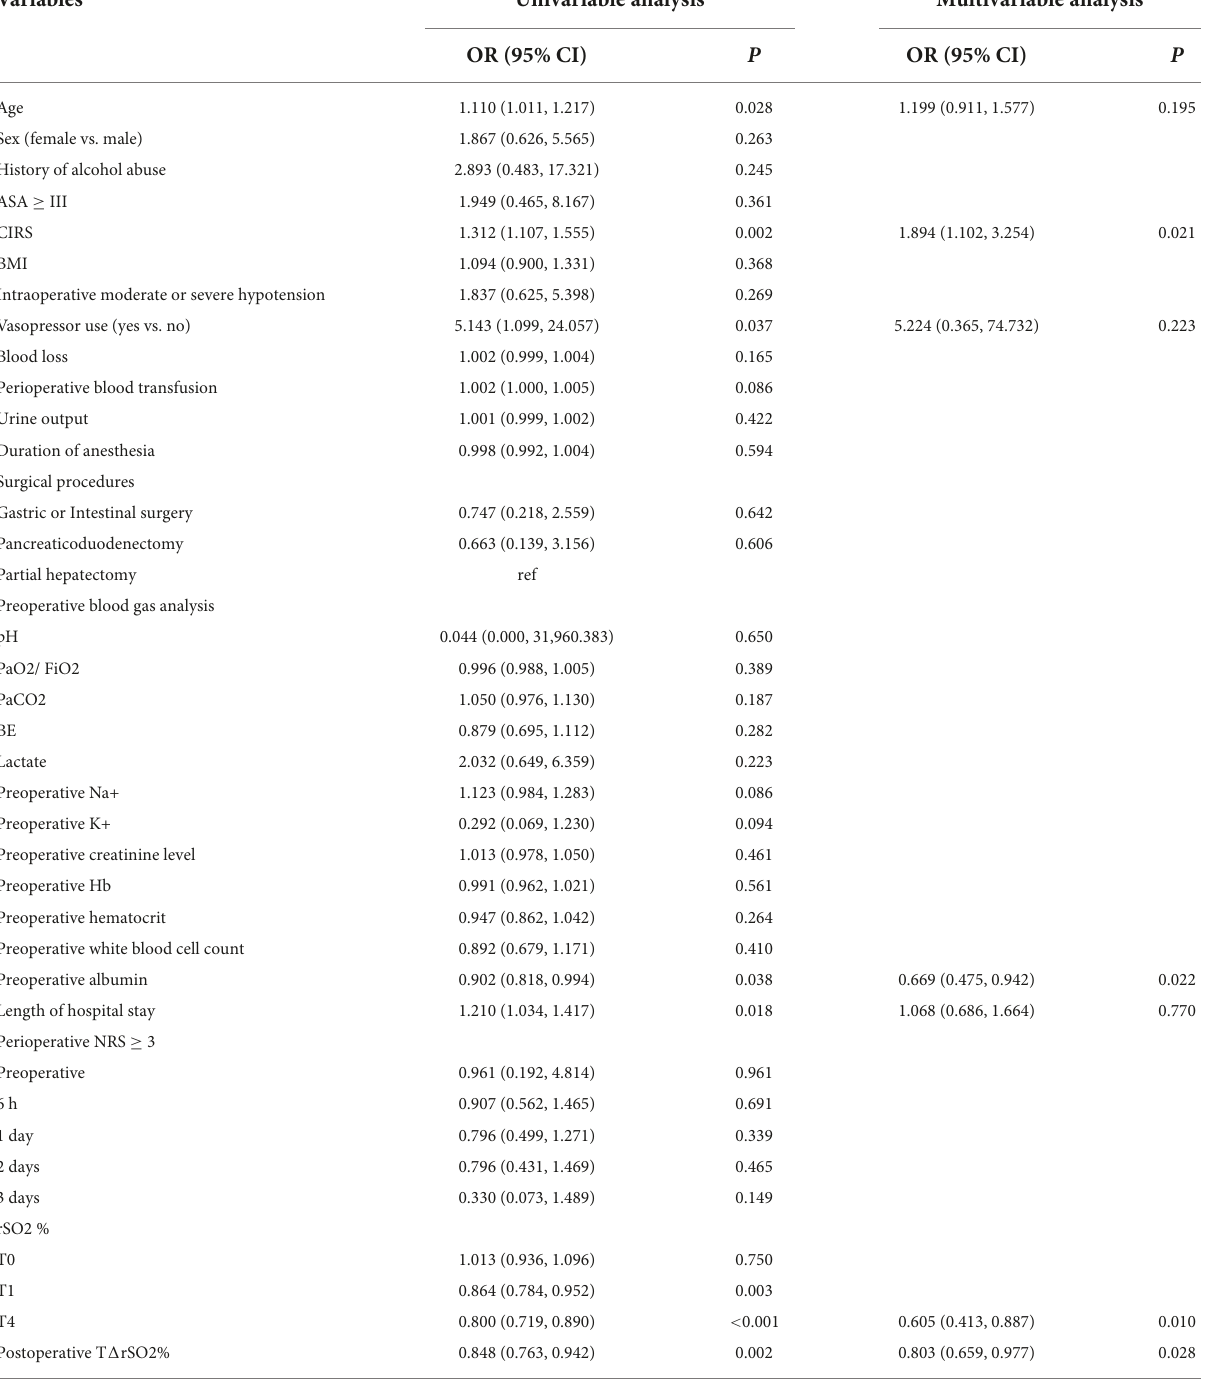
TABLE 4 Univariate and multivariable analysis of factors associated with delirium.